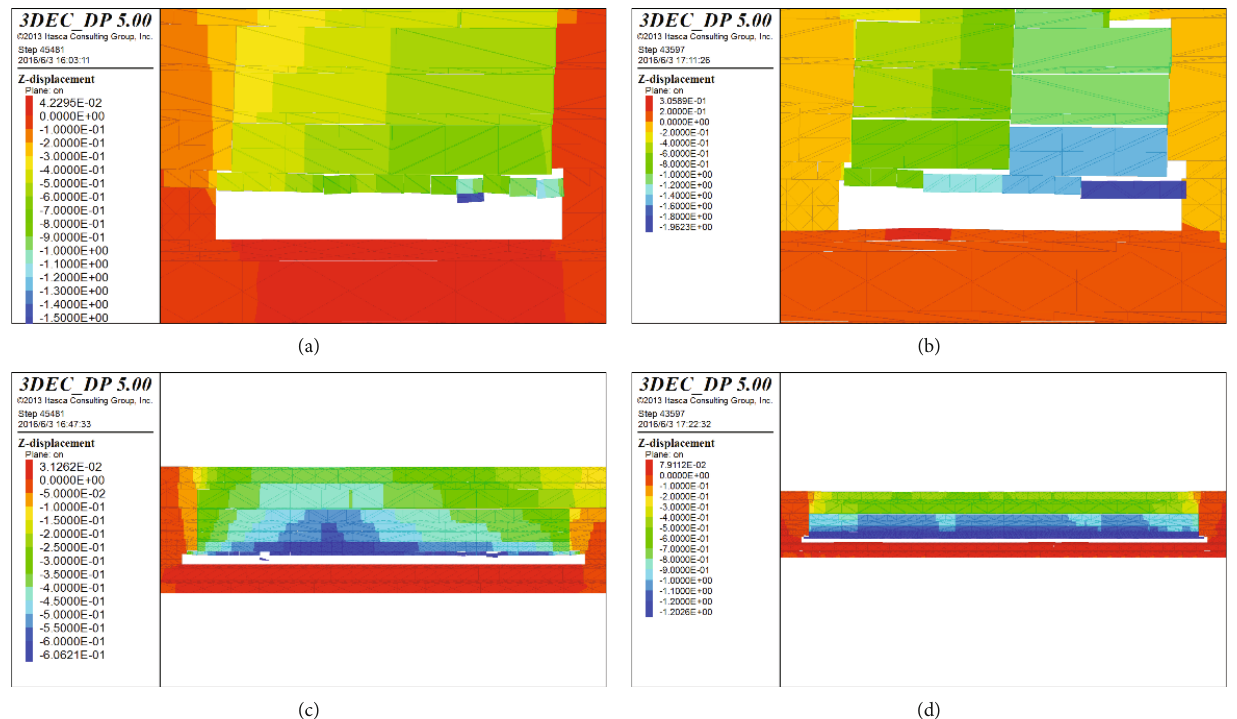
Figure 7: Nephogram of roof strata displacement when advancing to 37.5m(unit: m): (a) slice of the 195m working face in advancing direction, (b) slice of the 376m working face in advancing direction, (c) lengthwise slice of the 195m working face, and (d) lengthwise slice of the 376m working